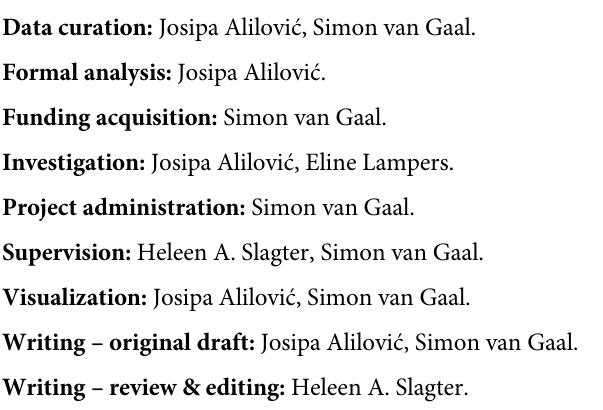
S5 Fig. Face/house classification based on the sensory localizer. ( A ) On-diagonal time courses of correct and incorrect decisions, separated by confidence (LC, low confidence; HC, high confidence). Black boxes indicate the time-windows (early, mid, late) used for averaging the AUC scores. ( B ) Perceptual maintenance is derived by training a classifier on the time- window 150–200 ms and testing it across the entire time-window. In (A) and (B), colored hori- zontal lines indicate periods of significant decoding with respect to chance. Classification per- formance was evaluated at each time point using cluster-based permutation testing (two-tailed cluster-permutation, alpha p < 0.05, cluster alpha p < 0.05, N permutations = 1,000). ( C ) Bar plots showing average AUC values for the time-windows of interest highlighted in panels (A) and (B). The underlying data and scripts supporting this figure can be found on Fig Share (https://doi.org/10.21942/uva.c.6265233.v1).